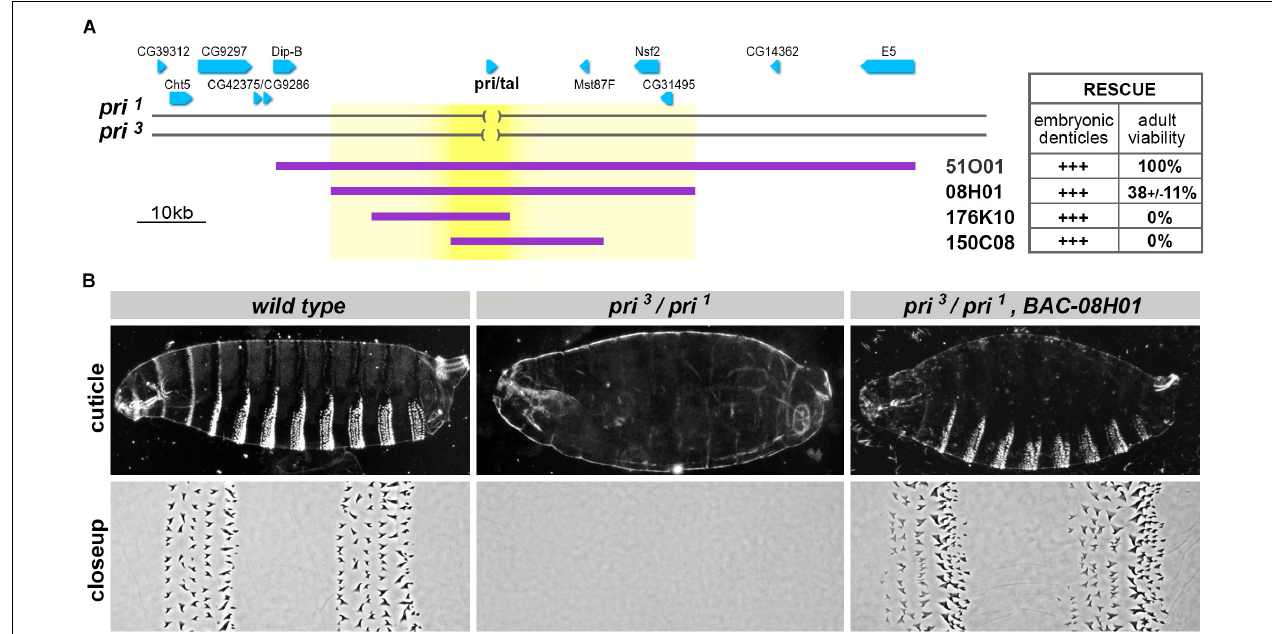
FIGURE 2 | The polished rice functional unit extends over a large genomic region. (A) Schematic representation of the genomic region encompassing the pri locus. Genes are drawn as blue arrows that reflect the direction of transcription, and deleted regions in the pri 1 and pri 3 null alleles are indicated as brackets. Purple lines show the genomic regions carried by Bacterial Artificial Chromosome (BAC) transgenes; the table summarizes their respective activity for the rescue of embryonic trichomes and the observed percentage of emerging adults (51O01, 100% n = 197; 08H01, 38 ± 11% n = 201; 176K10, 0% n = 305; 150C08, 0% n = 126). (B) Cuticle preparations of whole embryos (top) and close ups of the ventral region of abdominal segments A3–A4 (bottom). The denticle belts featuring wild-type embryos are lacking in pri 1 /pri 3 mutant embryos. BAC-08H01 significantly restores trichome formation in this pri null background, although denticle belts appear not always complete. In this and all other figures, embryos are oriented with the anterior on the left, and the ventral region at the bottom of each